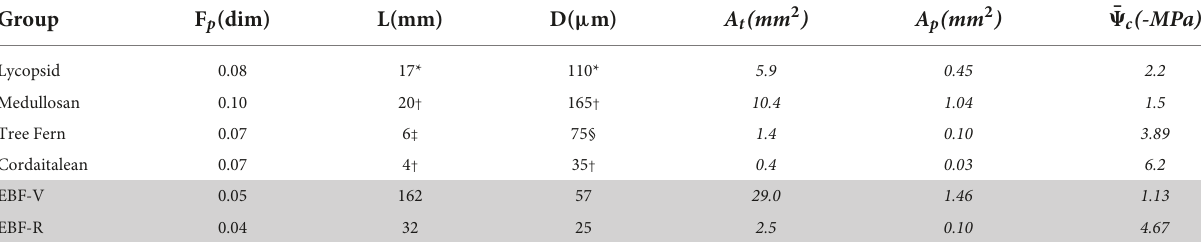
TABLE 1 Morphophysiological characteristics of fossil xylem from extinct plants and comparison with extant taxa.